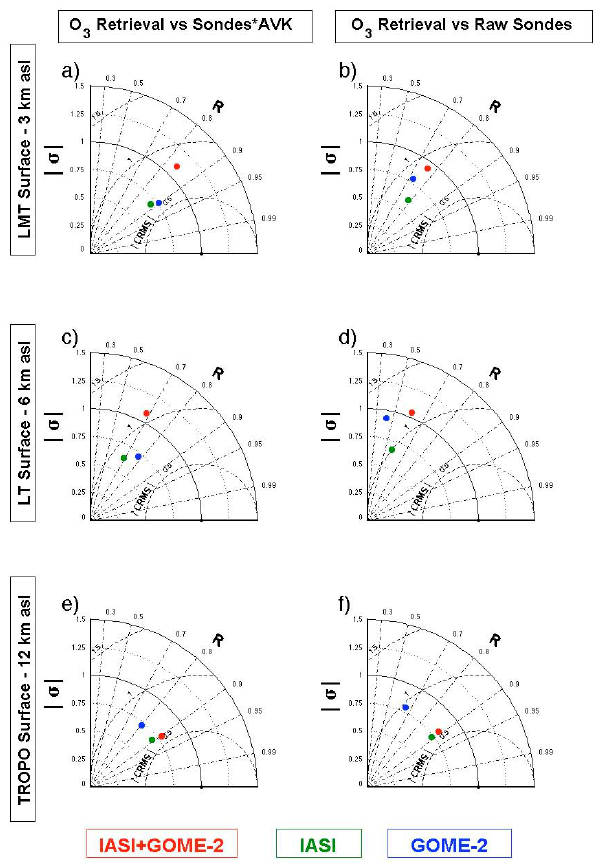
Fig. 8. Taylor diagrams summarizing normalized standard devia- tions of the satellite retrievals | σ | , linear correlation coefficients R and centred RMS differences (CMRS) between ozone mea- surements from IASI+GOME-2 (red), IASI (green) and GOME-2 (blue) and 105 ozonesondes (smoothed by the retrieval AVK on the left and raw to the right) during summer 2009 over Europe, for the ( a and b ) LMT, ( c and d ) LT and ( e and f ) TROPO partial columns. | σ | and CMRS are normalized by the ozonesonde measurements’ (smoothed or raw) standard